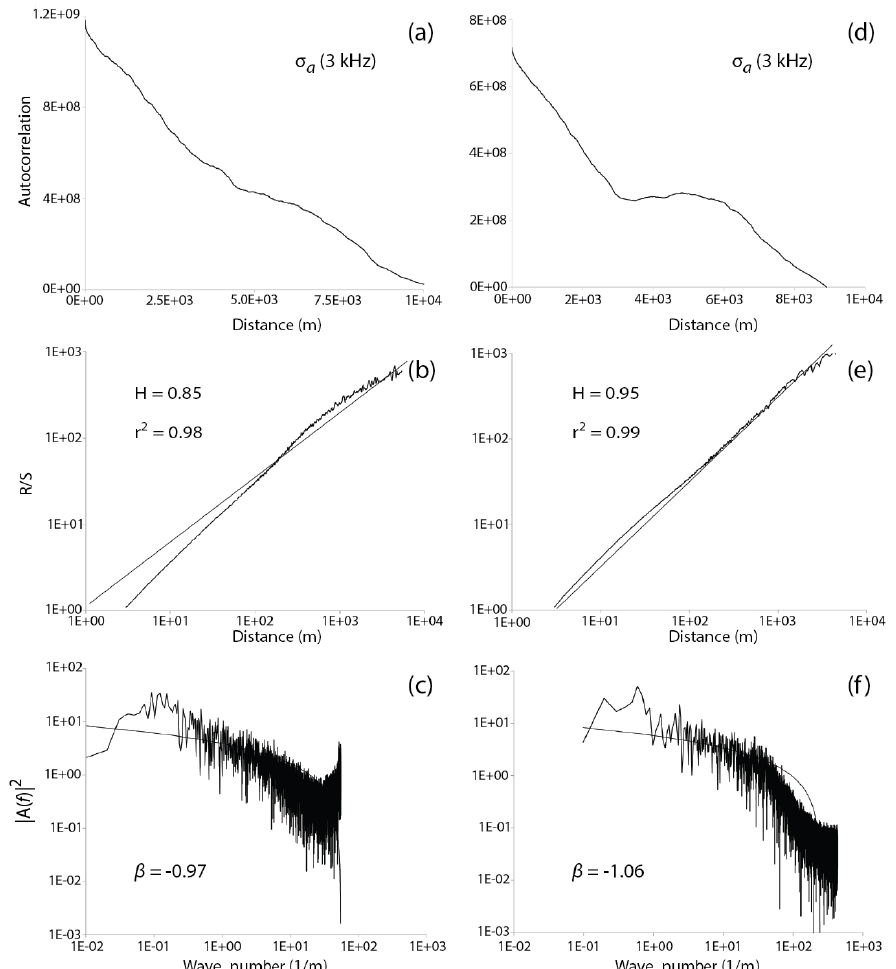
Figure 5. Autocorrelations of σ a for the 100km (a) and 10km EMI surveys (d) . R/S analysis for the 100km (b) and 10km surveys (e) . PSD plots for the 100km (c) and 10km surveys (f)